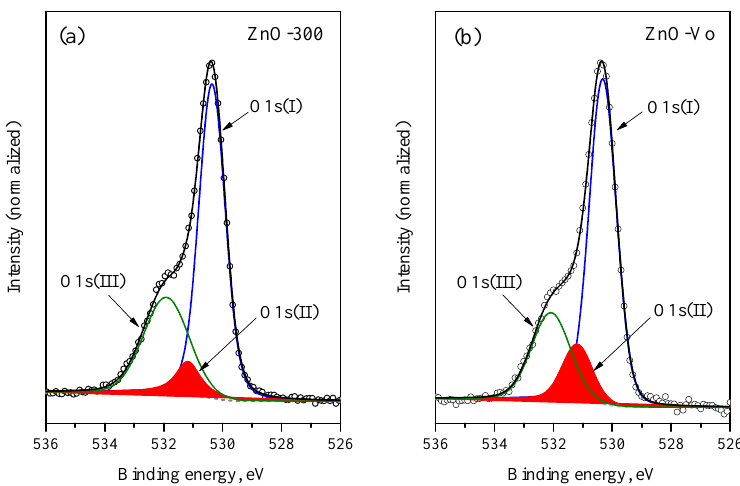
Figure 6. XP-spectra of ZnO-300 ( a ) and ZnO-V O ( b ) samples in the O1s region. Table 2. BE positions and relative content of O atoms in different charge states in ZnO-300 and ZnO-V O samples. BE Position, eV Content, at.% Sample